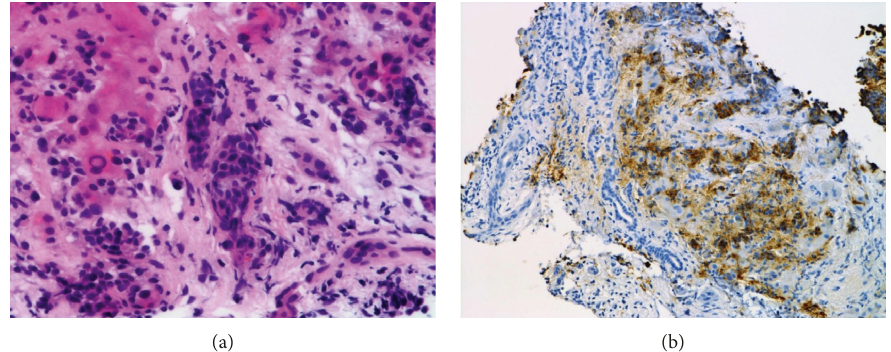
Figure 2: Histologic examination of a liver biopsy specimen shows a well-differentiated tumor (a) with positive expression of chromogranin A (b).